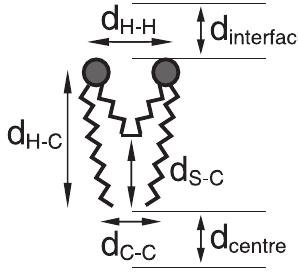
Figure 8. Schema of the distances, extracted from the MD, used to characterize the conformation and relative position of gemini molecules in the bilayer. A summary of the respective values for the 12-2-12, 12-10-12, 14-2-14, and 18-2-18 surfactants are presented in Table 2.